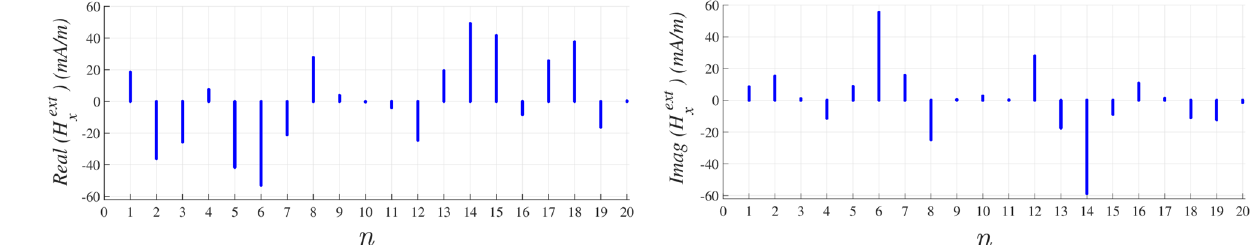
Figure 5. Real and imaginary part of evaluated Fourier series in Eq. (29) at each discreted ϕ